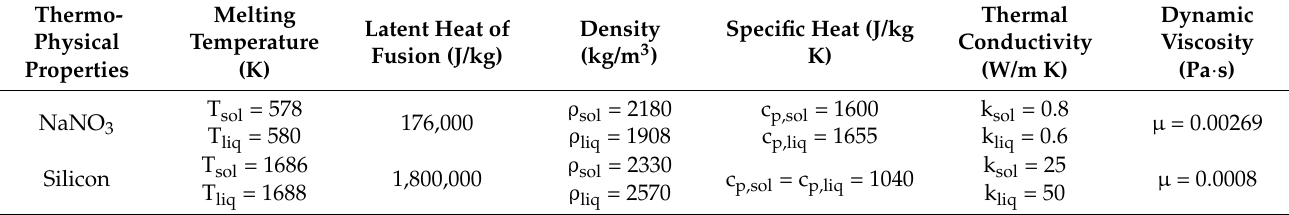
Figure 1. Numerical model ( a ) Computational geometry and ( b ) Discretized geometry. Table 1. Thermo-physical properties of silicon and NaNO 3 .